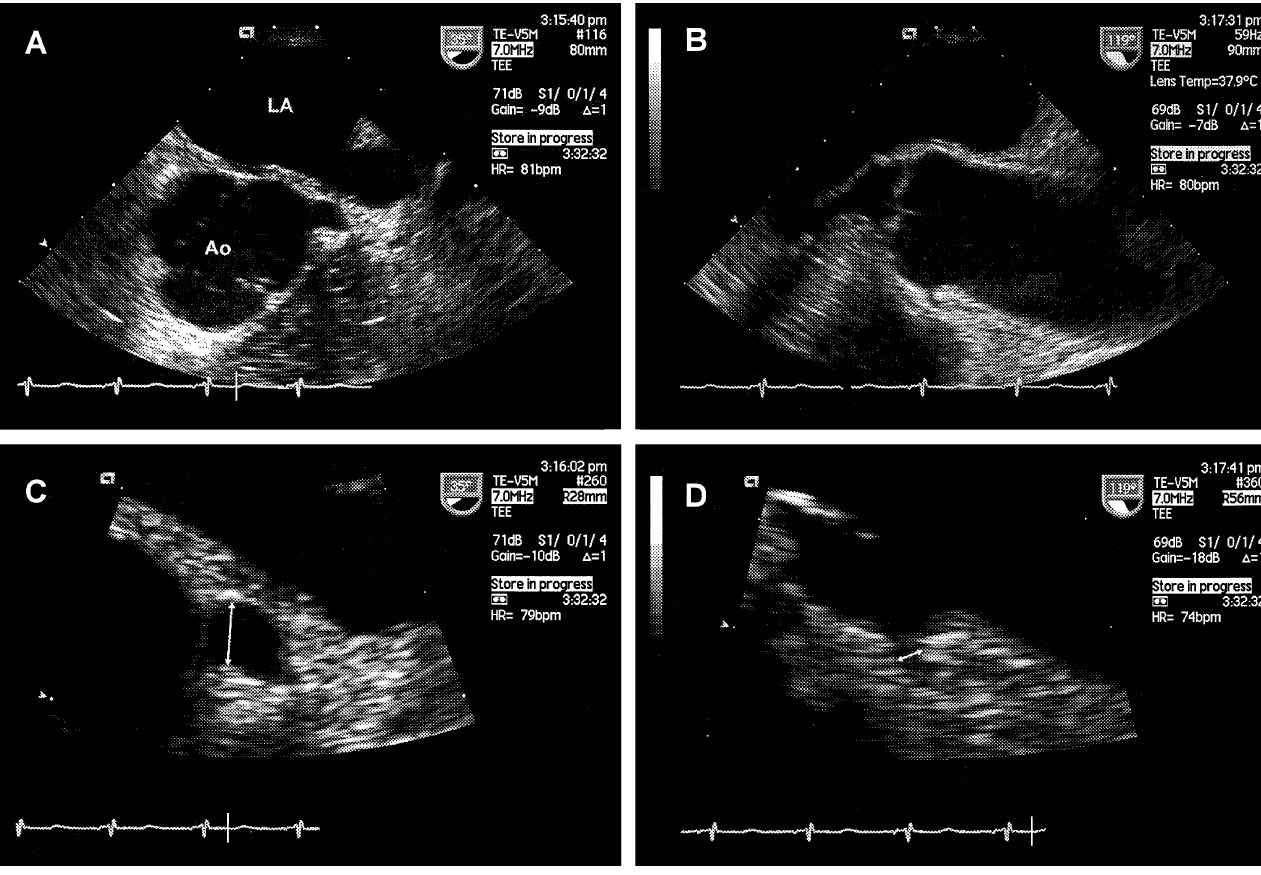
Transoesophageal short-axis view of the ascending aorta shows the origin of the left main coronary artery (A and C), and transoesophageal long-axis view shows the origin of the right coronary artery (B and D) at the aortic sinus. Arrows in C and D demonstrate the measurement of coronary artery